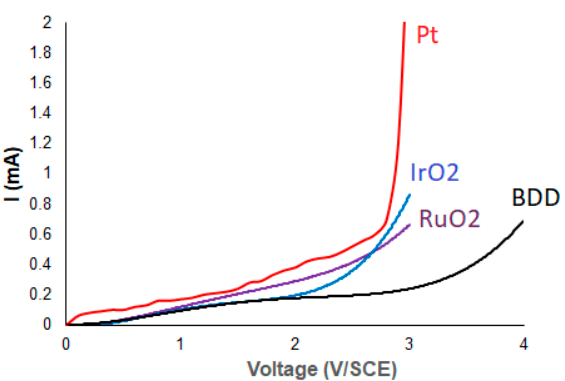
Figure 1. Linear sweep voltammetry of urine synthetic wastewaters using different anode materials. Reference Electrode: SCE, Counter electrode: Graphite, Scan rate: 50 mV/s, Temperature: 25 °C.